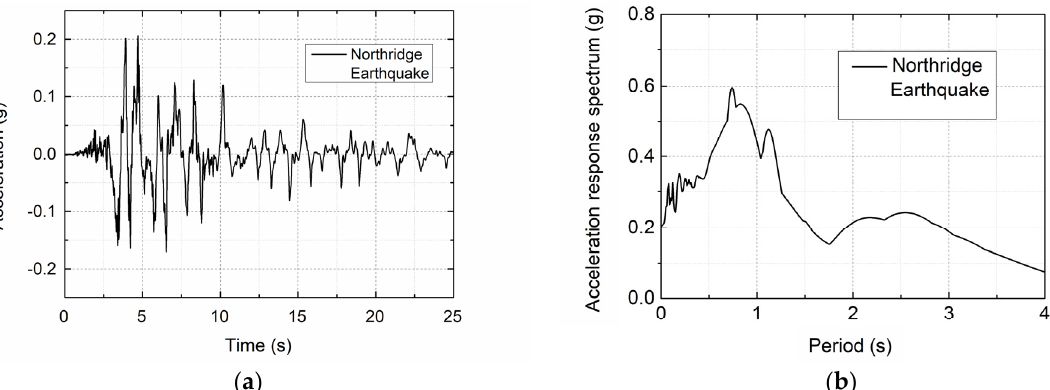
Figure 2. Accelerations and acceleration response spectrums of the Kobe earthquake. ( a ) Acceleration, ( b ) acceleration response spectrum.